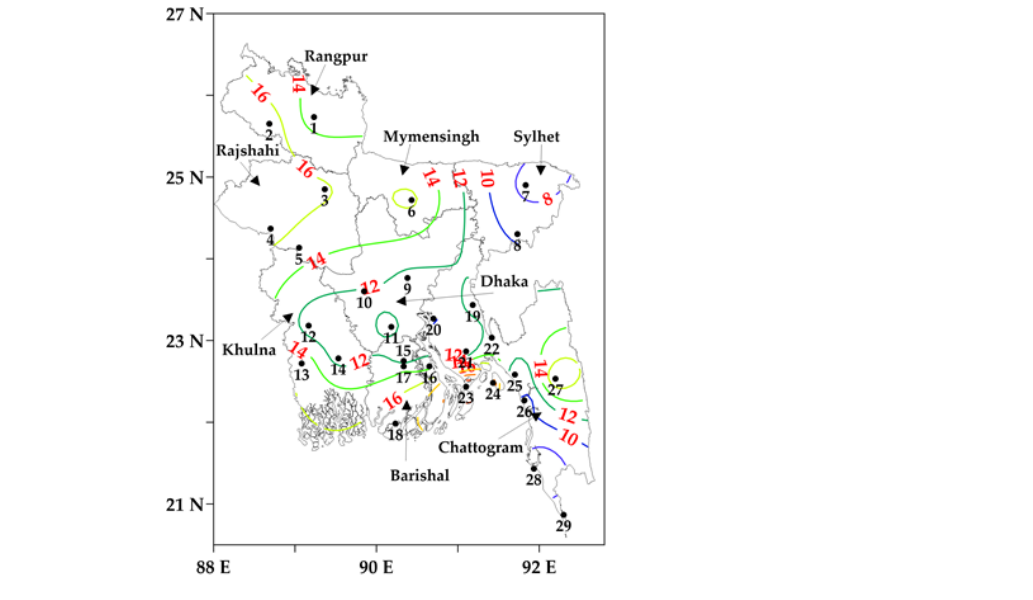
Figure 3. The initial calculation of the station-wise average cold days (in coloured contour lines with values) during the winter period from 2000–2001 to 2020–2021 across Bangladesh. The black numbers are the IDs of meteorological stations.